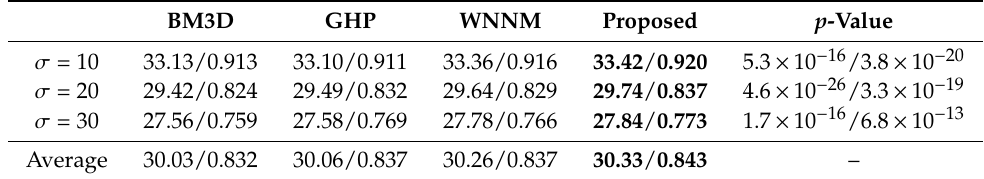
Table 5. The averages of computational time (in seconds) of WNNM and the proposed method. Proposed WNNM ( WNNM + Texture Recovery) 𝜎 =